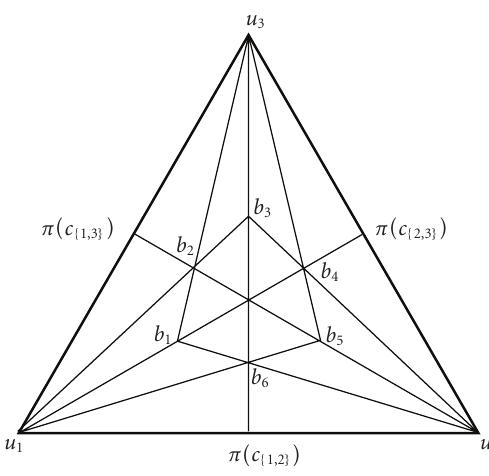
Figure 3.1. The k -ball in Δ centered at c with extremal points b 1 , ... , b 6